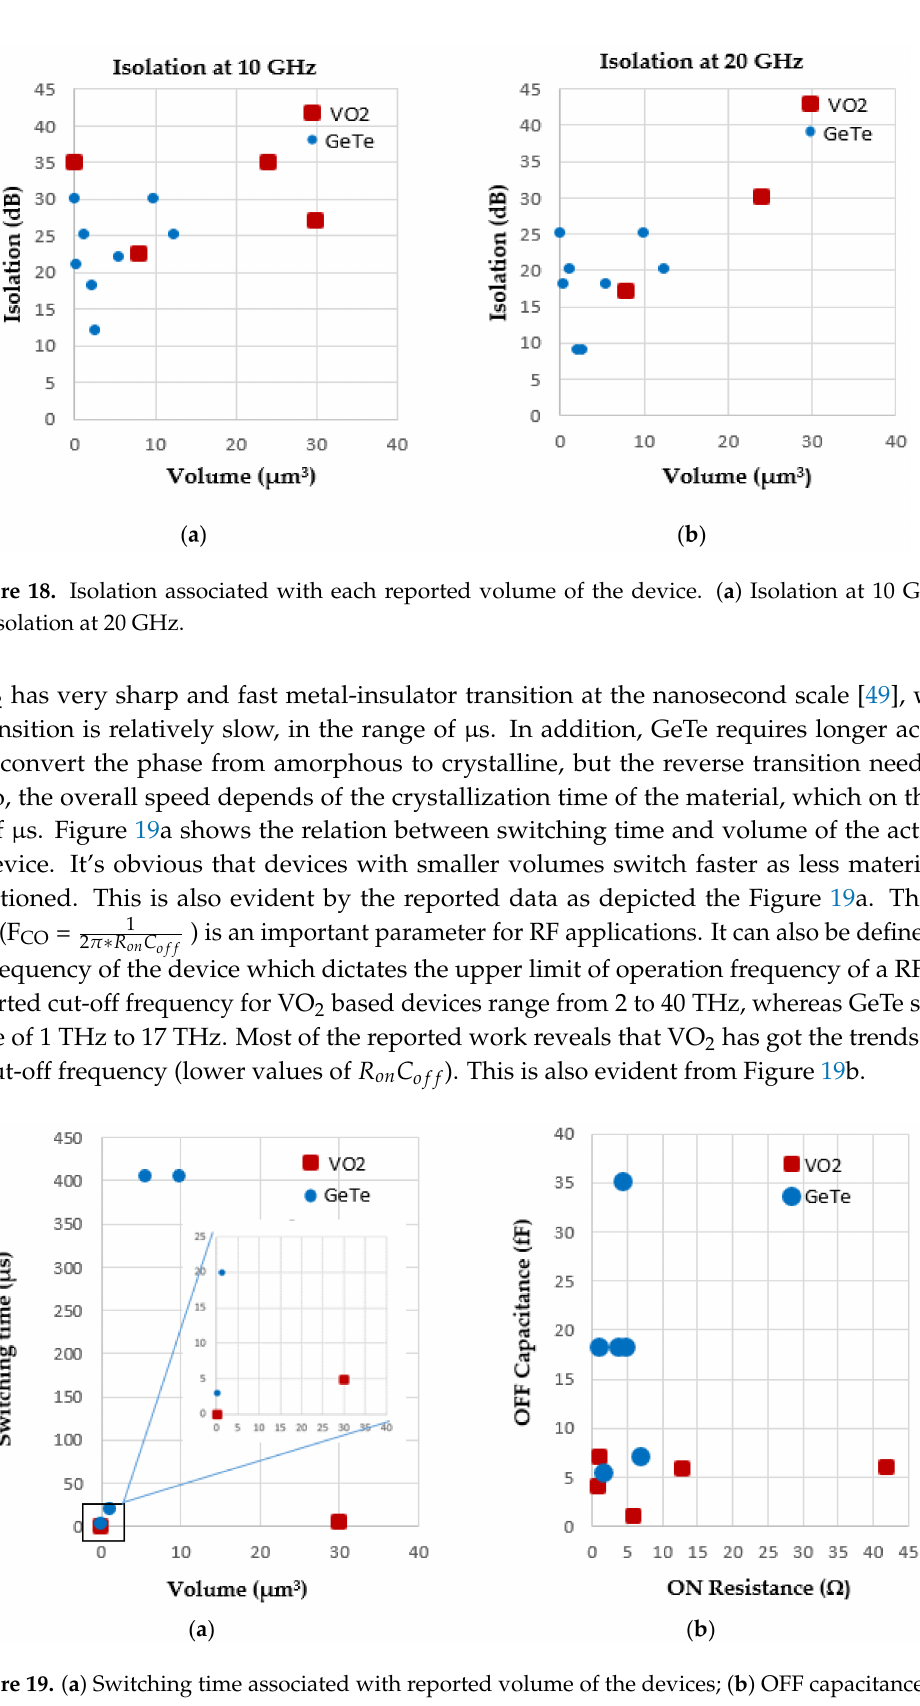
Figure 19. ( a ) Switching time associated with reported volume of the devices; ( b ) OFF capacitance vs. ON